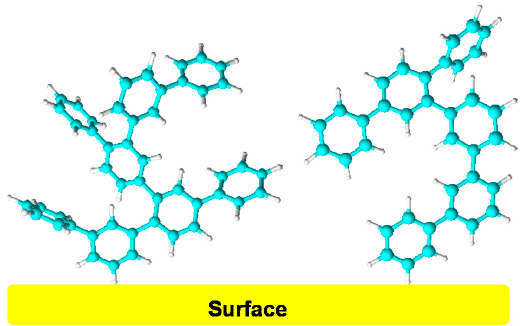
Figure 9. A schematic presentation of a film obtained from diazonium salts.